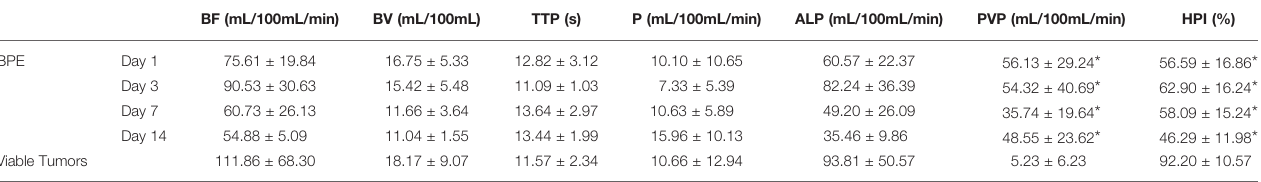
TABLE 2 | Comparison of postoperative perfusion parameters of BPE and viable tumors after RFA treatment. BF (mL/100mL/min) BV